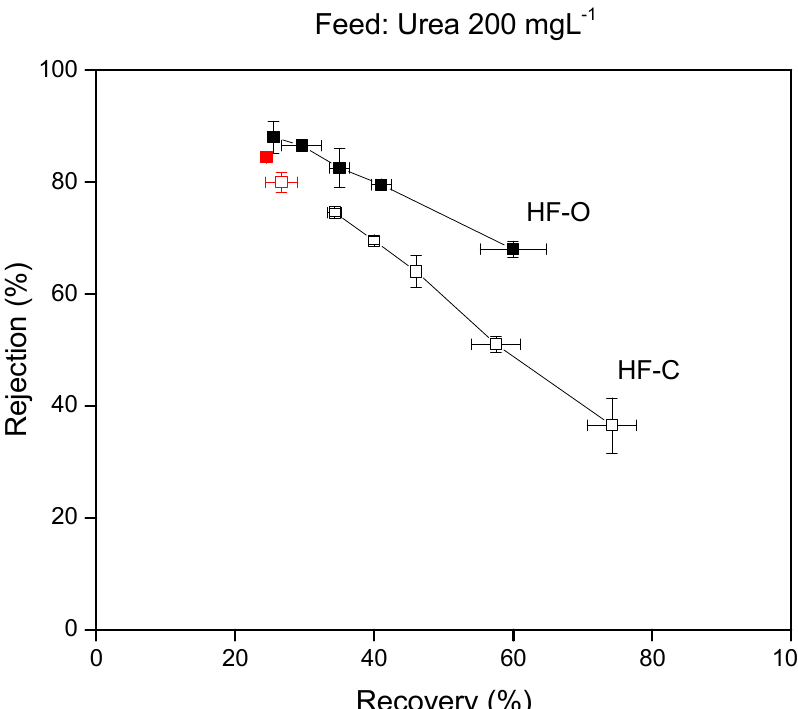
Figure 16. Rejection of urea in FO operation for HF–C and HF–O modules as a function of process recovery. The urea concentration was 200 mg · L − 1 . The feed flow rate for both modules was modified from 60–140 L · h − 1 to obtain a wide range of process recoveries. The draw flow rate was maintained at 25 L · h − 1 with a DS of 1M NaCl. Red data points are urea rejections from the FO tests shown in Figure 15, where a di ff erent draw flow rate, 16 L · h − 1 , and a di ff erent DS concentration, 0.5 NaCl, was used.